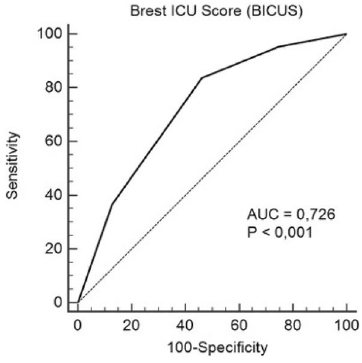
Fig. 1 ROC curve for Brest ICU Score